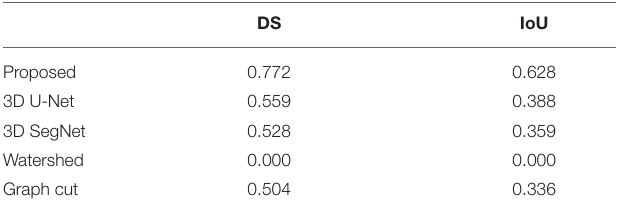
TABLE 4 | Comparison of the proposed method with four segmentation methods in the case of a nodule attached to the chest wall. DS IoU Proposed 0.772